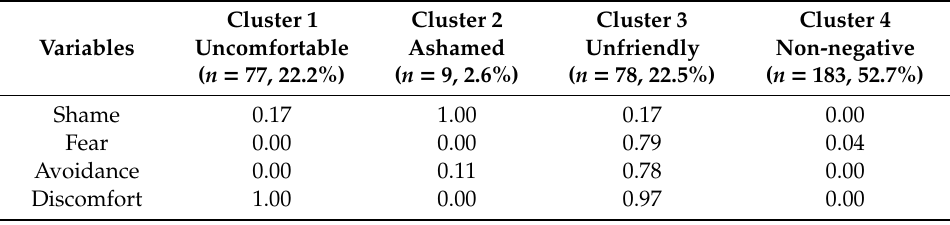
Table 3. Cluster analysis according to the attitudes towards dementia of the